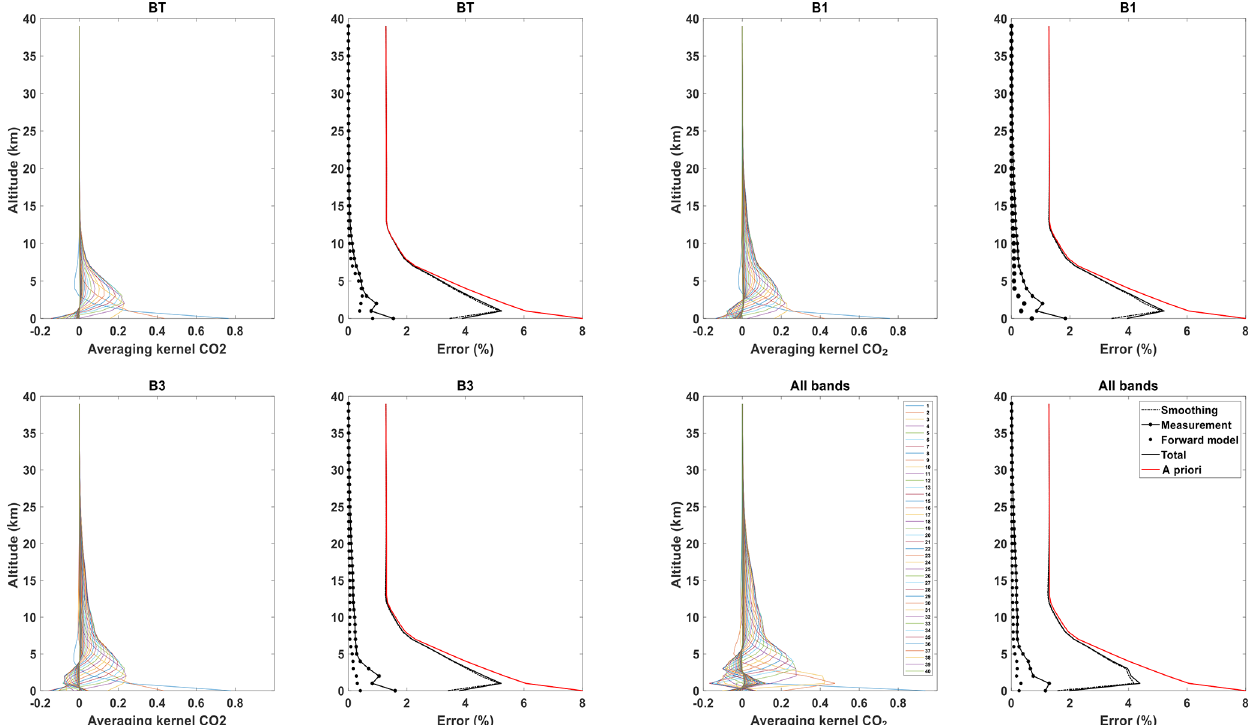
Figure 8. Averaging kernels and error budgets of vertical CO 2 profiles for bands TB, B1 and B3 separately and all the bands together for an angle of 10 ◦ for CHRIS. The red and solid black lines stand for the prior ( S a ) and posterior ( S x ) errors, respectively; the smoothing ( S smoothing ), measurement ( S meas. ) and forward model parameter ( S fwd.mod. ) errors are dash-dotted, dash-starred and dotted,